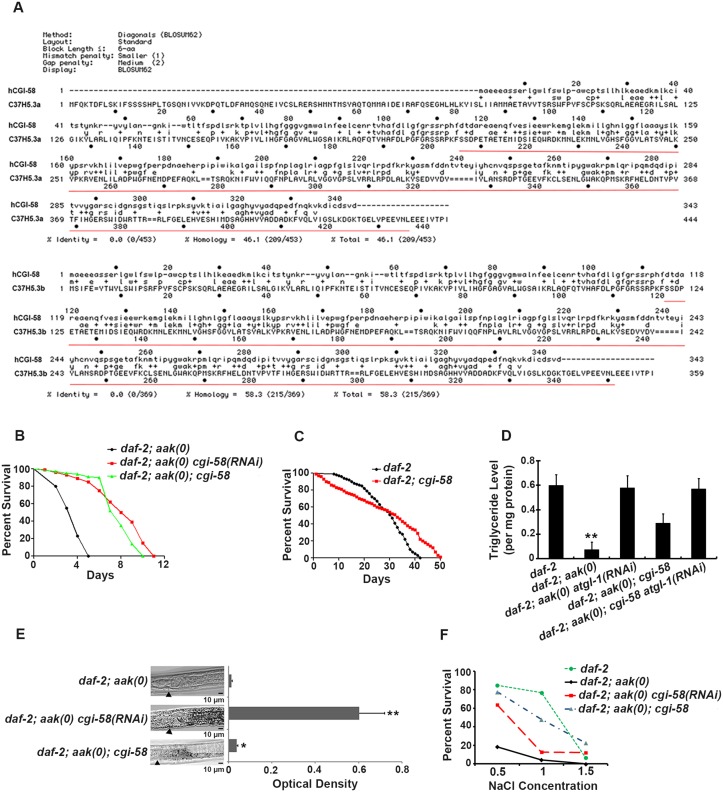
Elimination of cgi-58 rescued both triglyceride levels and excretory defects in daf-2; aak(0) mutant Dauer larvae.
(A) Protein alignment of the two isoforms of C. elegans CGI-58 (C37H5.a and C37H5.b) with human CGI-58. The red underlined amino acids indicate the deleted region in the ok3245 allele. (B) Elimination of cgi-58 by RNAi feeding or by using the ok3245 allele significantly enhanced the survival of daf-2; aak-1; aak-2 mutant dauer larvae. aak-1; aak-2 is represented as aak(0) in all Figs. A Log-rank (Mantel-Cox) test was used to statistically compare the survival curves in all Figs. (C) Mutation of cgi-58 in control daf-2 animals significantly enhanced their survival during dauer stage (P = 0.0003). (D)
cgi-58 protects the triglyceride stores from depletion in daf-2; aak(0) mutant dauer larvae. Colorimetric analysis of triglyceride content in day 4 dauer larvae. ** indicates statistical significance (P<0.01) compared to all four of the other genotypes using one-way ANOVA followed by a Tukey HSD test. Error bars indicate SD of three independent experiments. The same statistical analysis was applied for all subsequent experiments performed hereafter. (E) Elimination of cgi-58 protects the triglyceride stockpile in daf-2; aak(0) mutant dauer larvae. Oil Red O staining of day 4 dauer larvae. Arrowhead indicates the junction between the pharynx (left) and the intestine (right). Oil Red O staining intensity was evaluated by measuring optical density. * and ** indicate statistical significance (P<0.05 and P<0.01, respectively) compared to daf-2; aak(0) mutant dauer larvae. Error bars indicate SD of 20 animals. Scale bar = 10 μm. (F) Osmoregulatory defects typical of AMPK dauer larvae were corrected by reducing cgi-58 function. cgi-58 compromise restores osmoresistance of day 4 daf-2; aak(0) mutant dauer larvae following culture in varying NaCl concentrations for 24 hours at 25°C. The data represent a pool of three independent experiments. Survival of daf-2, daf-2; aak(0) cgi-58(RNAi) and daf-2; aak(0); cgi-58 dauers is significantly higher than daf-2; aak(0) dauers at concentrations of both 1M and 1.5M NaCl, analyzed using one-way ANOVA followed by a Tukey HSD test.